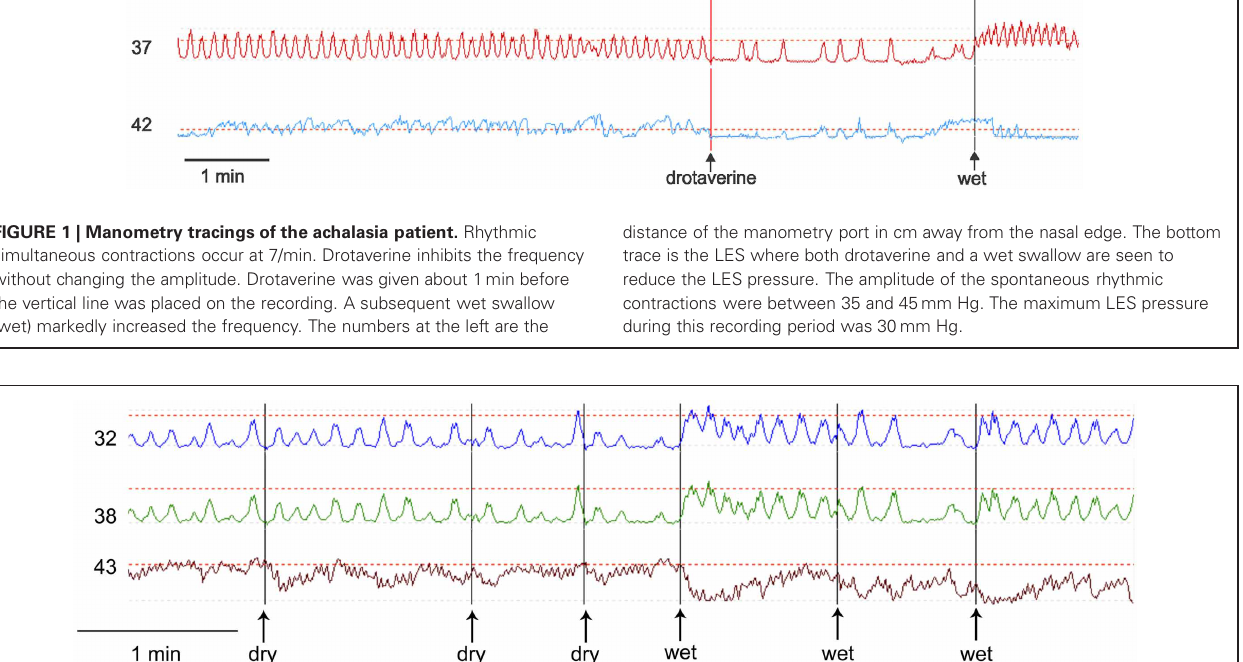
contractions. Thefirst andthird wetswallowsmarkedly increase thefrequency. The amplitude of the spontaneous contractions were between 20 and 40mm Hg. The maximum LES pressure during this recording period was 50mm